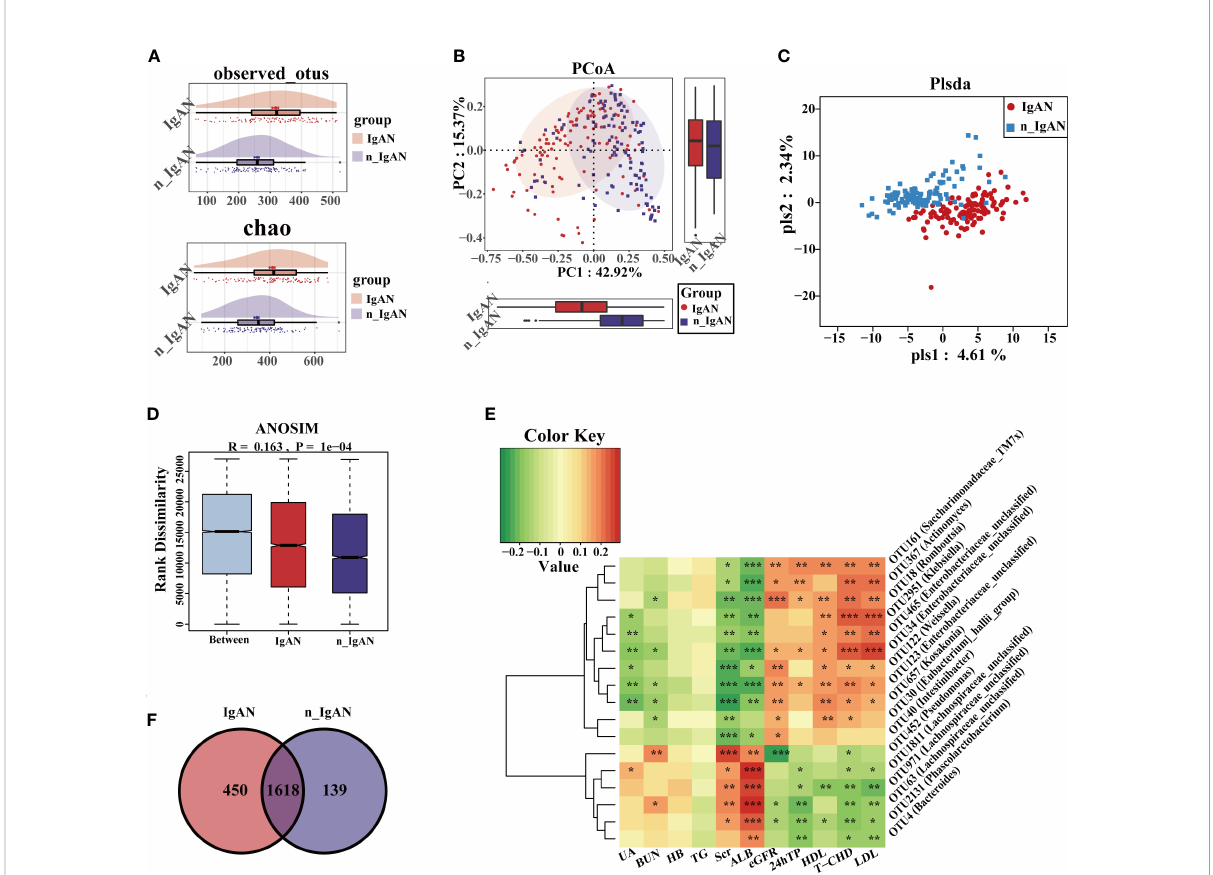
FIGURE 6 Differences in composition of gut microbiome at OUT level in IgAN and n_IgAN. (A) Observed OTUs and chao index were increased in IgAN. (B) Two- dimensional PCoA based on weighted UniFrac distance. (C) PLSDA graph of the composition of gut microbiota. (D) ANOSIM graph showed differences between groups is greater than differences within groups. (E) A Venn diagram based on the distribution of intestinal microbe OTUs in two groups. (F) Spearman correlations between different OTUs and clinical indicators. The correlation with signi fi cant difference is indicated by an asterisk (* P < 0.05; ** P < 0.01; *** P < 0.001). PCoA, Principal Coordinates Analysis; PLSDA, partial least squares discriminant analysis; ANOSIM, analysis of similarity; HB, hemoglobin; BUN, blood urea nitrogen; Scr, Serum creatinine; UA, uric acid; ALB, serum albumin; T-CHO, total cholesterol; TG, triglycerides; HDL, high density lipoprotein; LDL, low density lipoprotein; eGFR, estimated glomerular fi ltration rate; 24hTP, 24-hour urinary total protein levels; HC, healthy controls; n_IgAN, non-IgA